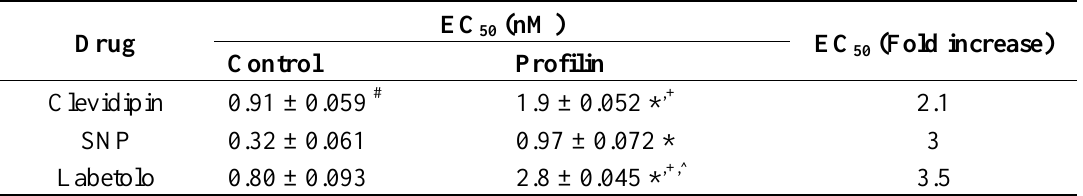
Table 1. The EC of clevidipine, sodium nitroprusside (SNP) and labetolol in control and 50 profilin1 mesentric arteries. There is a significant difference in the effect of clevidipine compared to SNP and labetalol. Data are presented as means ± S.E, (n = 8). EC (nM) 50 Drug EC (Fold increase) 50 Control Profilin Clevidipin 0.91 ± 0.059 # 1.9 ± 0.052 * ,+ 2.1 SNP 0.32 ± 0.061 0.97 ± 0.072 * 3 Labetolo 0.80 ± 0.093 2.8 ± 0.045 * ,+,^ 3.5